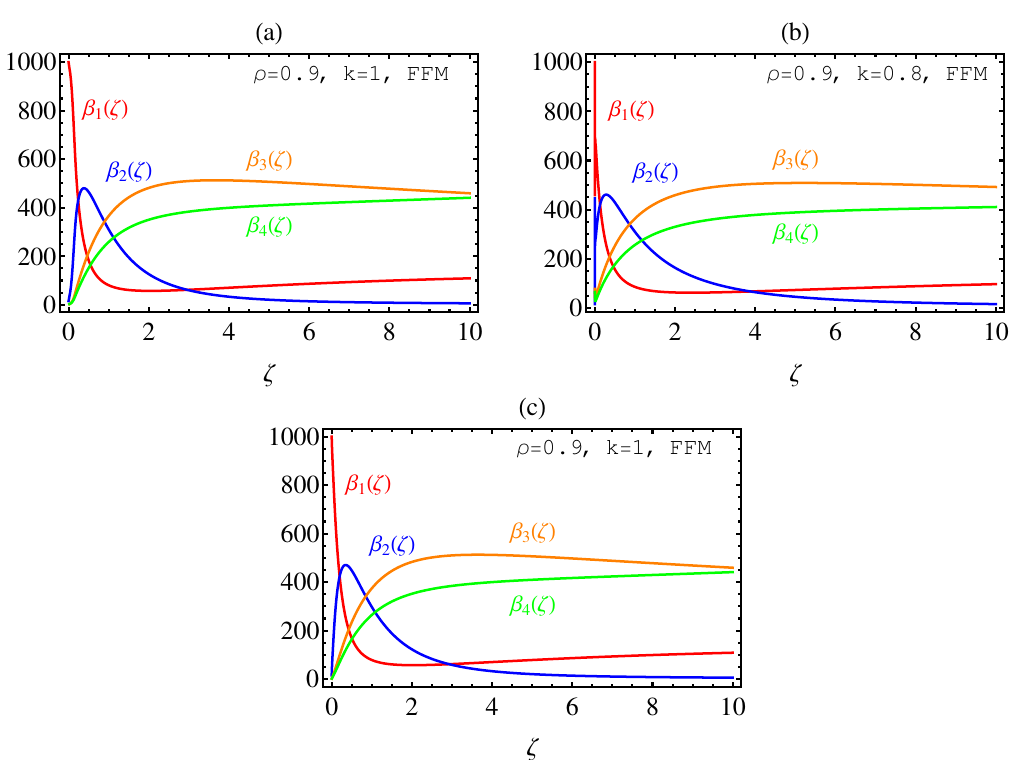
Figure 4. Graph of the numerical solutions based on FFM for ( a ) ρ = 0.9, k = 1, ( b ) ρ = 0.9, k = 0.8 and ( c ) ρ = 1, k = 0.8, respectively, with λ = 0.01, s = 0.02, δ = 0.6, α = 0.4, β = 0.01, N = 1000, h = 0.02 and the following initial conditions: β 1 ( 0 ) = 1000, β 2 ( 0 ) = 15, β 3 ( 0 ) = 0and β 4 ( 0 ) =